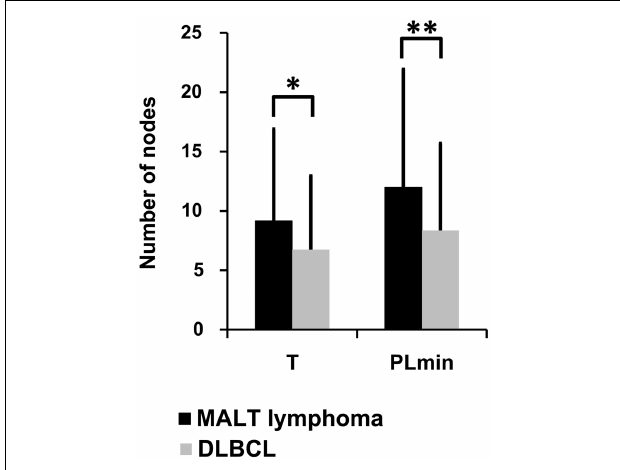
FIGURE 4 | Lineage tree analysis – comparison between dominant clones from the three MALT-L samples (24 trees) and the five DLBCL samples (47 trees) .There was more than one tree per sample, as we included all clones with the sameVH and JH genes (but different alleles) in the dominant clone in each sample, because they might be related to the dominant clone and falsely attributed to other alleles. Significant differences were found in trunk length (T) and minimal path length (PLmin). An asterisk (*) represents p -value < 0.01; two asterisks (**) represents p -value < 0.005.